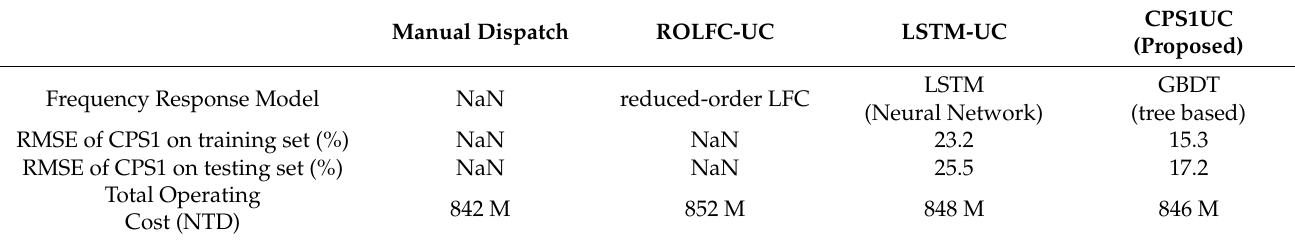
Table 2. CPS1 scores and requirements of PMS and CPS1UC in the first-shift period (Averaging over eight hours).